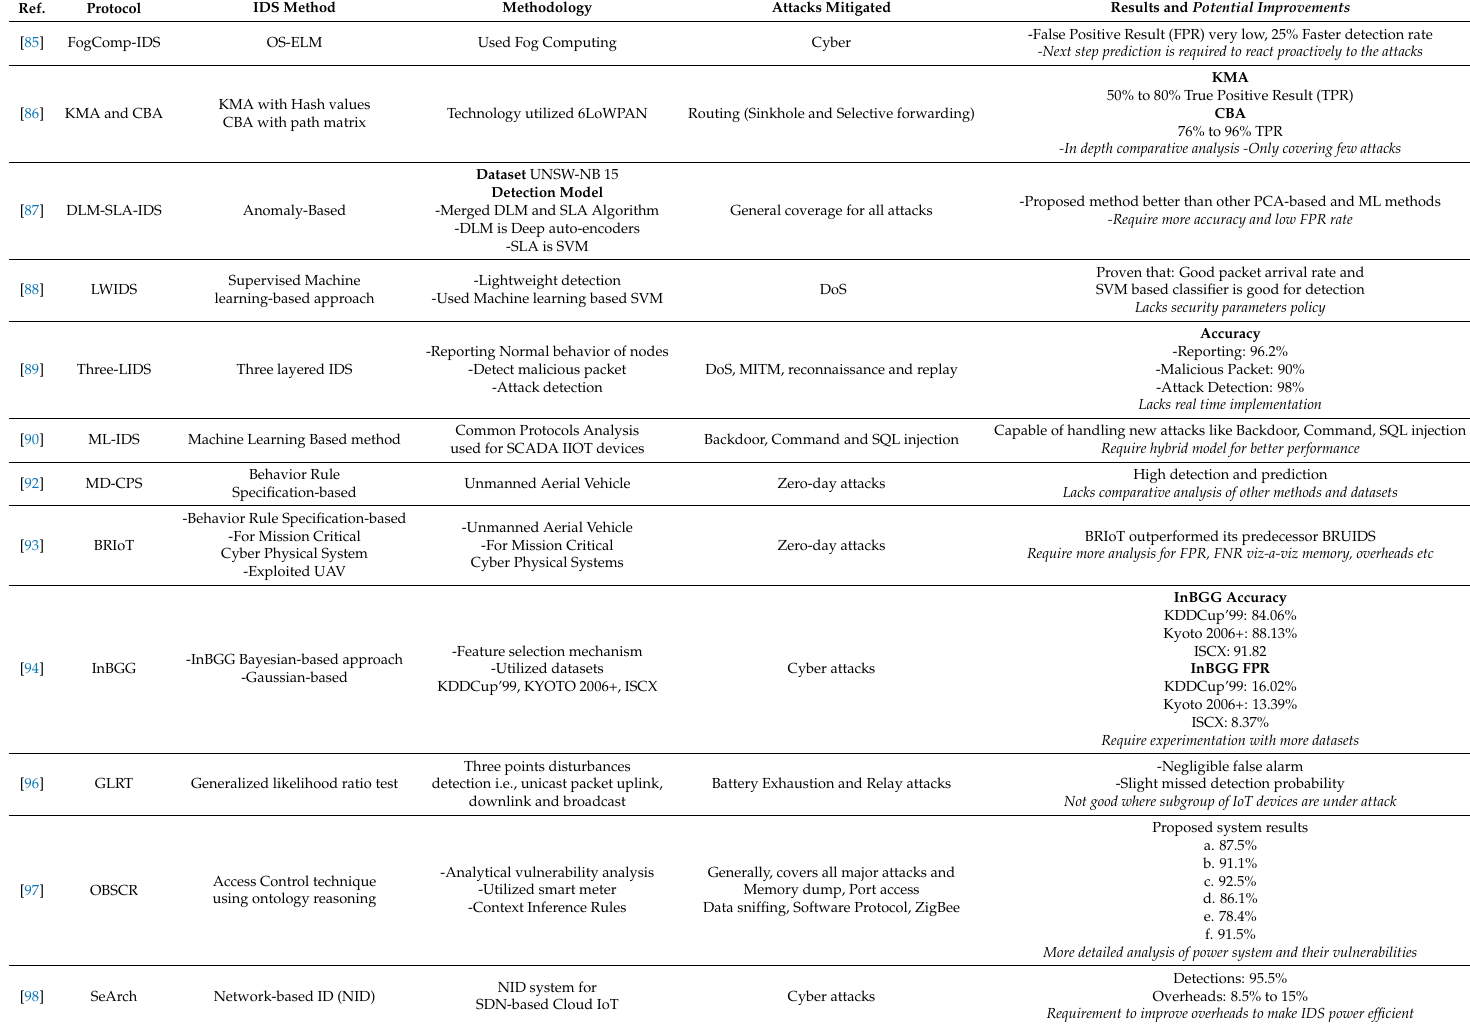
Table 3. Summary of Internet of Things (IoT)-Based IDS Systems.